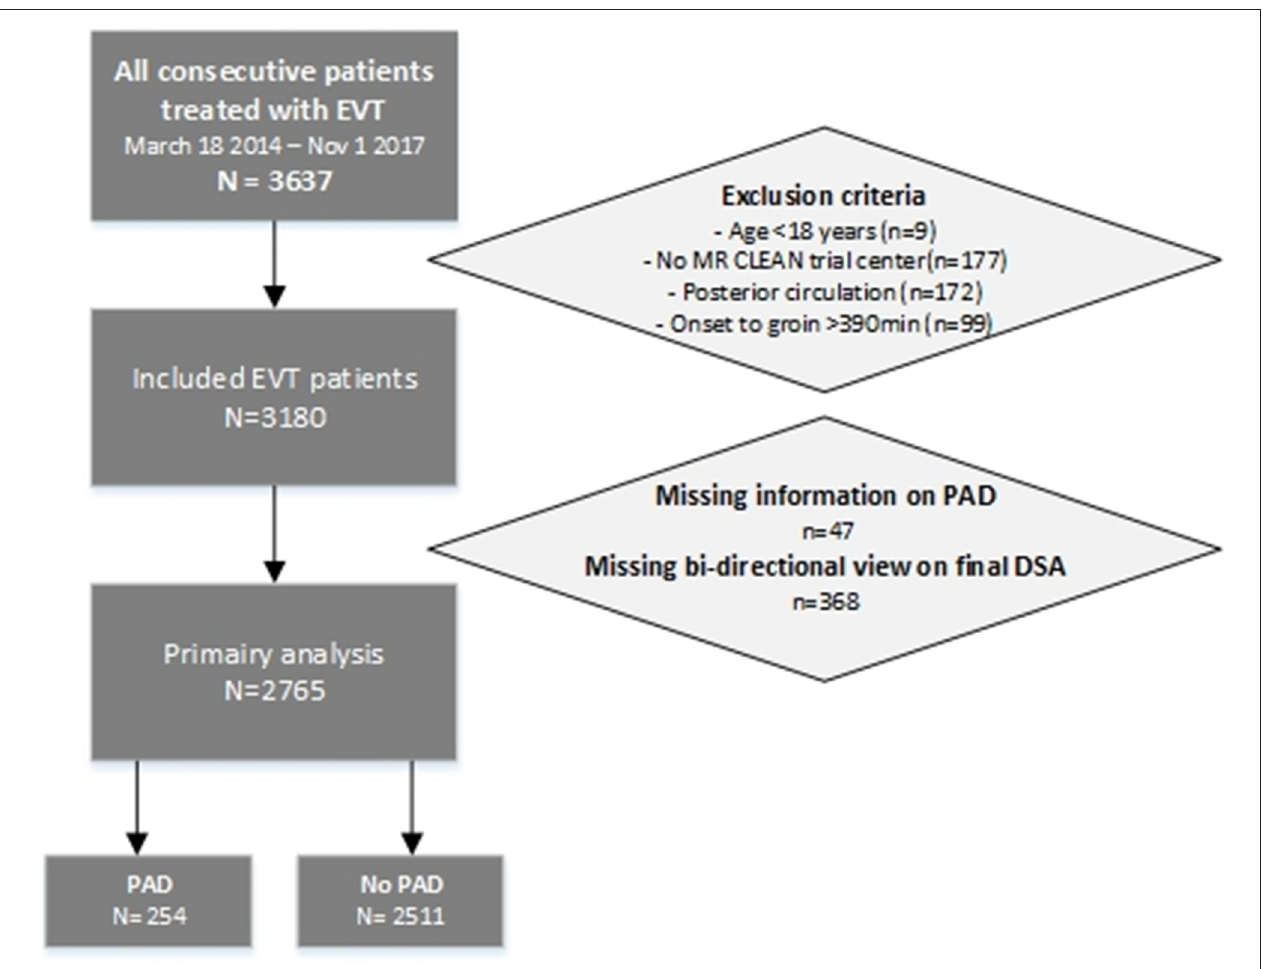
FIGURE 1 | Flowchart patient